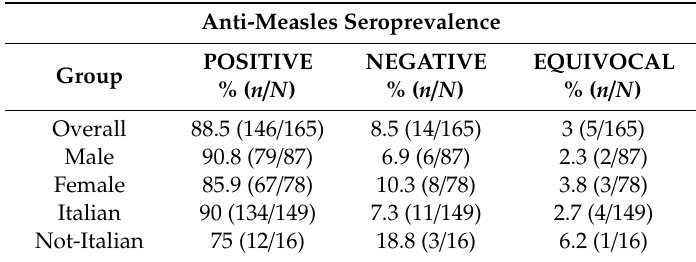
Table 2. Anti-measles seroprevalence in the enrolled population. ( n / N : number of subjects / total).